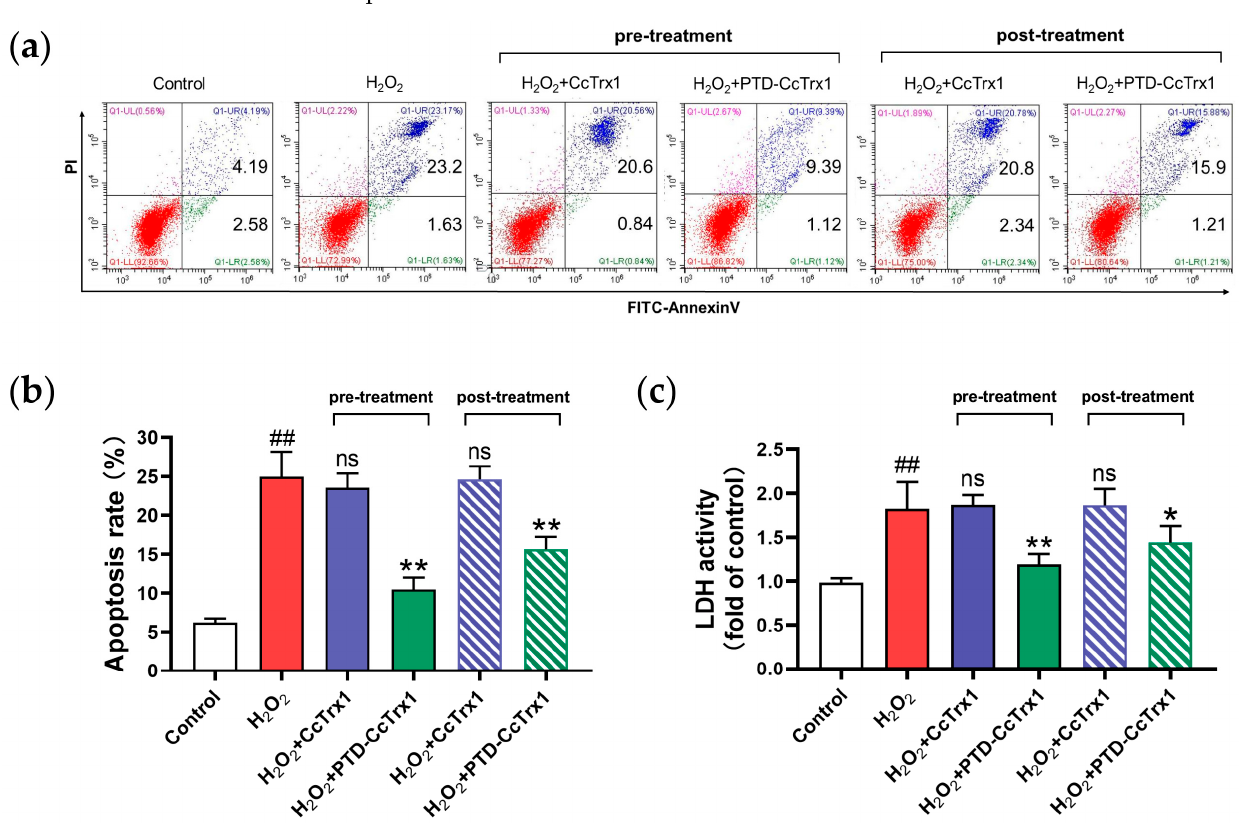
Figure 5. Protective effects of PTD-CcTrx1 against H 2 O 2 -induced apoptosis and necrosis in HaCaT cells. First, HaCaT cells were treated with 10 µ M PTD-CcTrx1 and 10 µ M CcTrx1 before or after the exposure to 400 µ M H 2 O 2 . After treatment, the cells were resuspended in the binding buffer of the apoptosis analysis kit and stained with Annexin V-FITC/PI, and then analyzed by flow cytometry. ( a ) PTD-CcTrx1 significantly inhibited H 2 O 2 -induced apoptosis of HaCaT cells. ( b ) Histogram of the apoptosis rate in different groups. ( c ) LDH activity of cell supernatants in different groups. All treatments were performed in triplicate individually, with values expressed as mean ± SD (## p < 0.01 vs. control; ns, no significance, * p < 0.05, ** p < 0.01 vs. H 2 O 2 alone group).